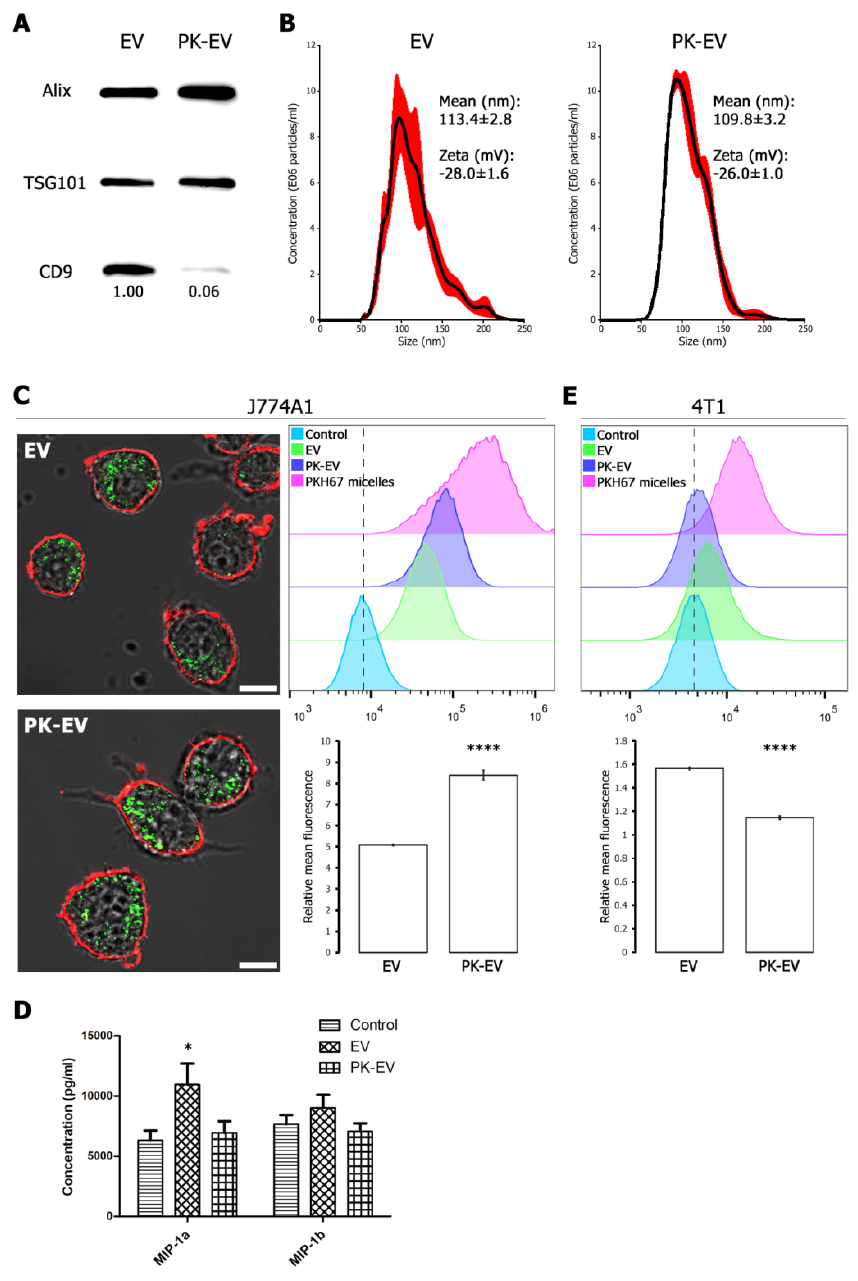
Figure 2. Presence of EV surface membrane proteins a ff ects uptake by cells. ( A ) Western blot for intraluminal markers Alix and TSG101, and transmembrane protein CD9 in EV versus PK-EV (equal particle numbers loaded). Decrease in CD9 signal was quantified using Image J. ( B ) NTA size distribution of EV versus PK-EV, depicted as mean (black line) with standard error (red shaded area). Inset: mean size ± standard error; mean zeta potential ± standard error. ( C ) Left panels: representative confocal images of J774A1 macrophages after 16 h incubation with EV or PK-EV. Red = Cholera toxin-B Alexa Fluor 555 conjugate membrane staining; Green = PKH67 membrane-labelled (PK-)EV. Scale bar = 10 µ m. Right panels: EV and PK-EV uptake by J774A1 macrophages quantified by flow cytometry with appropriate negative and positive controls (see Methods section). Dotted line indicates mean fluorescence of control. Relative mean fluorescence of cells treated with EV versus PK-EV is shown with standard deviation. Asterisks indicate significantly di ff erent values (****, two-sided t -test, p = 0.00002). ( D ) Concentration of cytokines MIP-1a and MIP-1b in supernatant of J774A1 macrophages after 16 h stimulation with control medium versus medium containing EV or PK-EV. Mean concentration is shown with standard error. Asterisk indicates significantly different values (*, two-sided t -test, p = 0.03). ( E ) EV and PK-EV uptake by 4T1 cancer cells quantified by flow cytometry